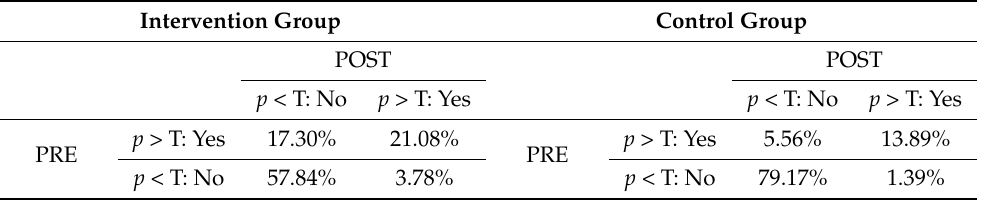
Table 4. Improvement or worsening in depressive symptomatology (in %).